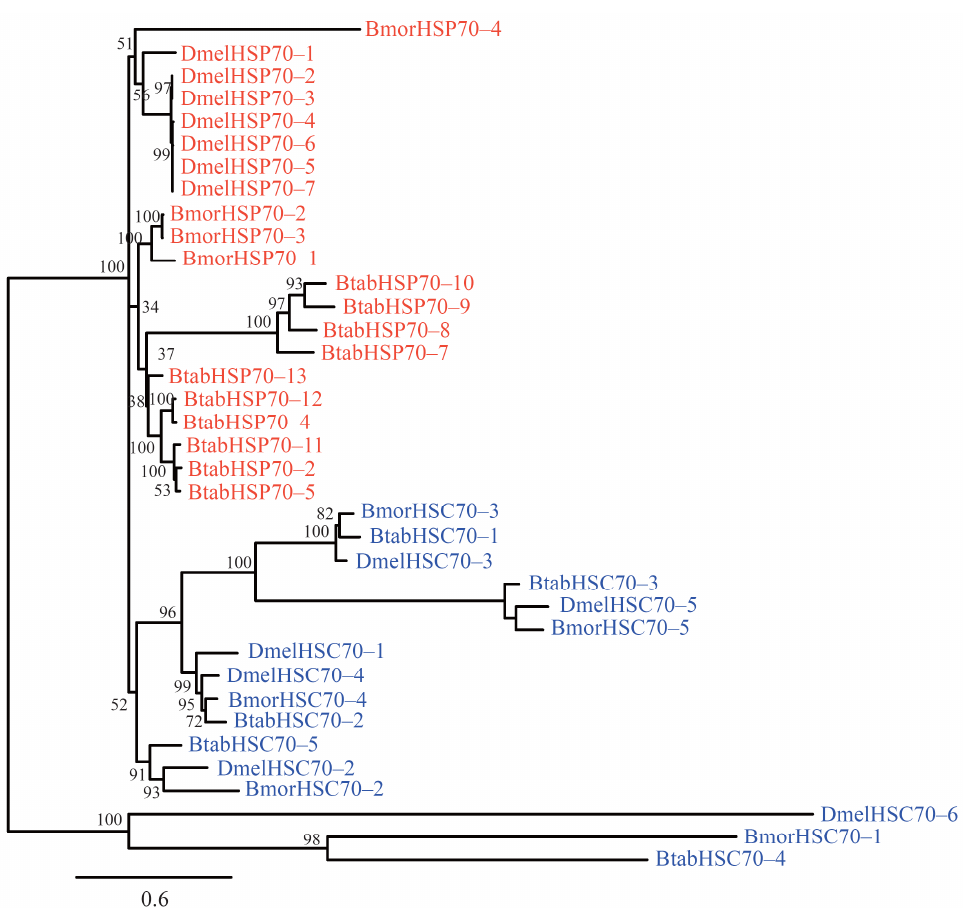
Figure 1. Maximum-likelihood phylogenetic tree of the HSP70/HSC70 proteins. The bootstrap values were displayed on the nodes. Bmor : Bombyx mori ; Dmel : Drosophila melanogaster ; Btab : Bemisia tabaci . Names of HSC70s were displayed in blue, all the HSP70s were displayed in red.